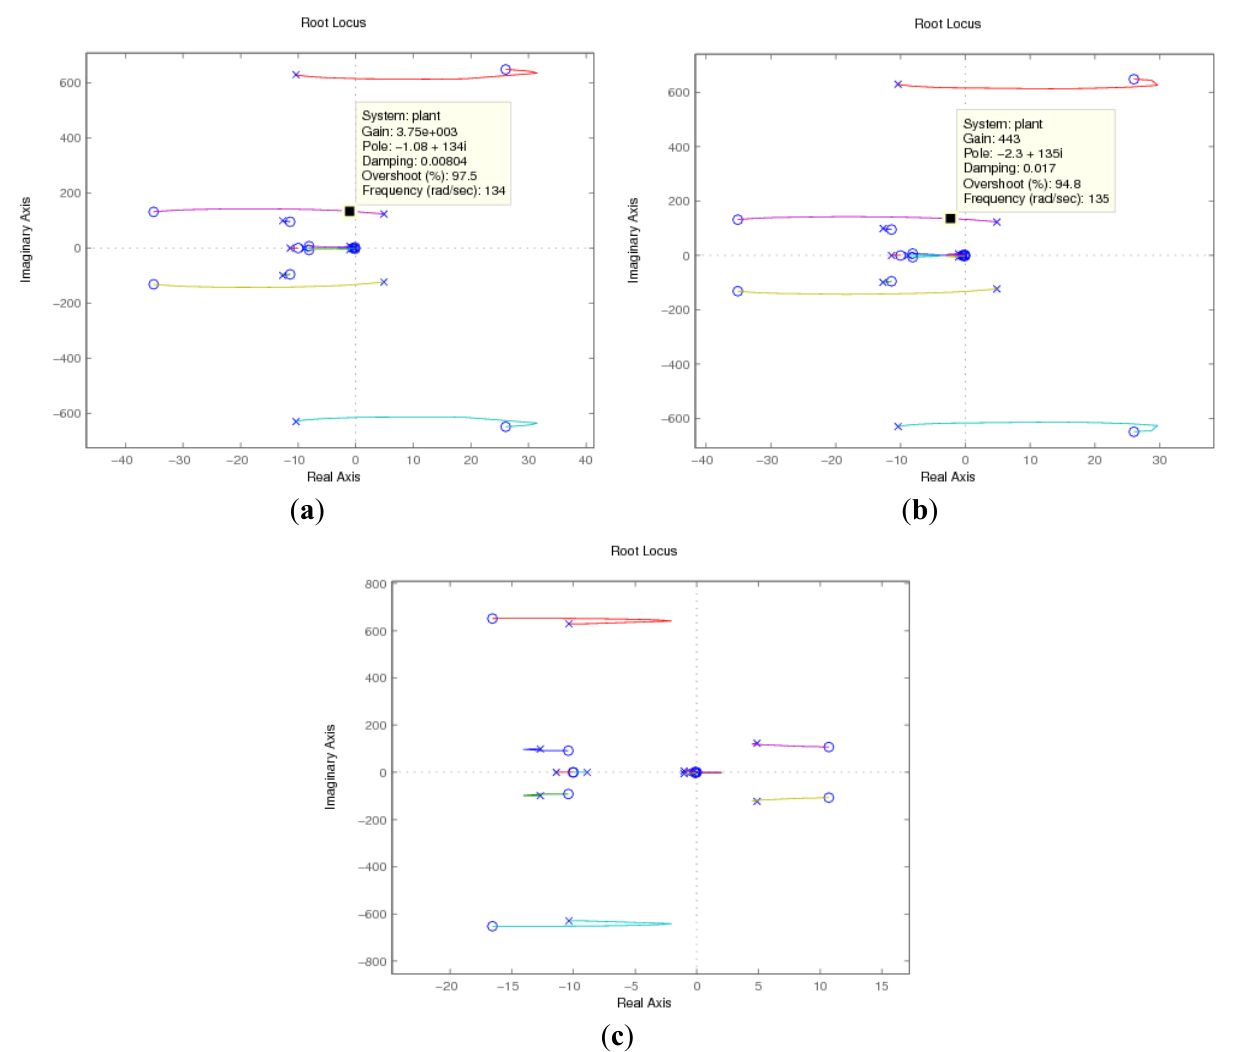
Figure 5. The root locus diagrams of the open-loop system with the rotor speed as the feedback signal and different modulated-voltage injection ( a ) to the d-axis of the GSC outer loop, ( b ) to the d-axis of the GSC inner loop, and ( c ) to the q-axis of the GSC inner